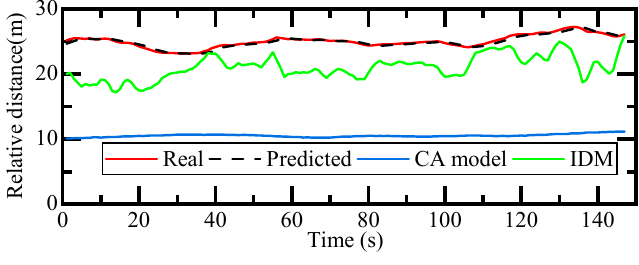
Figure 9. Results when following a truck.